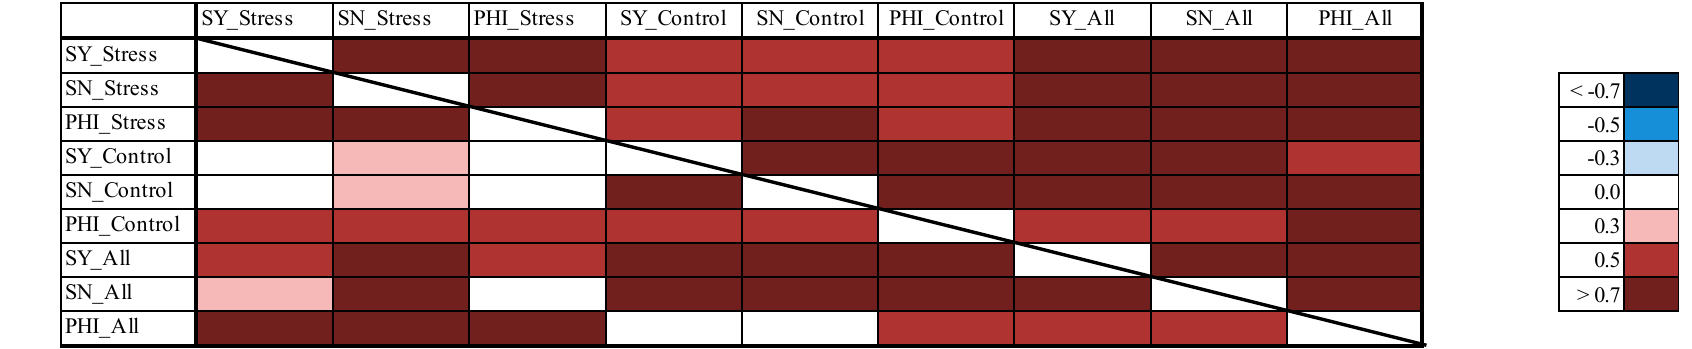
Figure 4 Heat map showing Pearson´s correlation for the measured traits for lines (below the diagonal) and hybrids (above the diagonal).SY = Seed yield per panicle; SN = seed number; PHI = panicle harvest index.